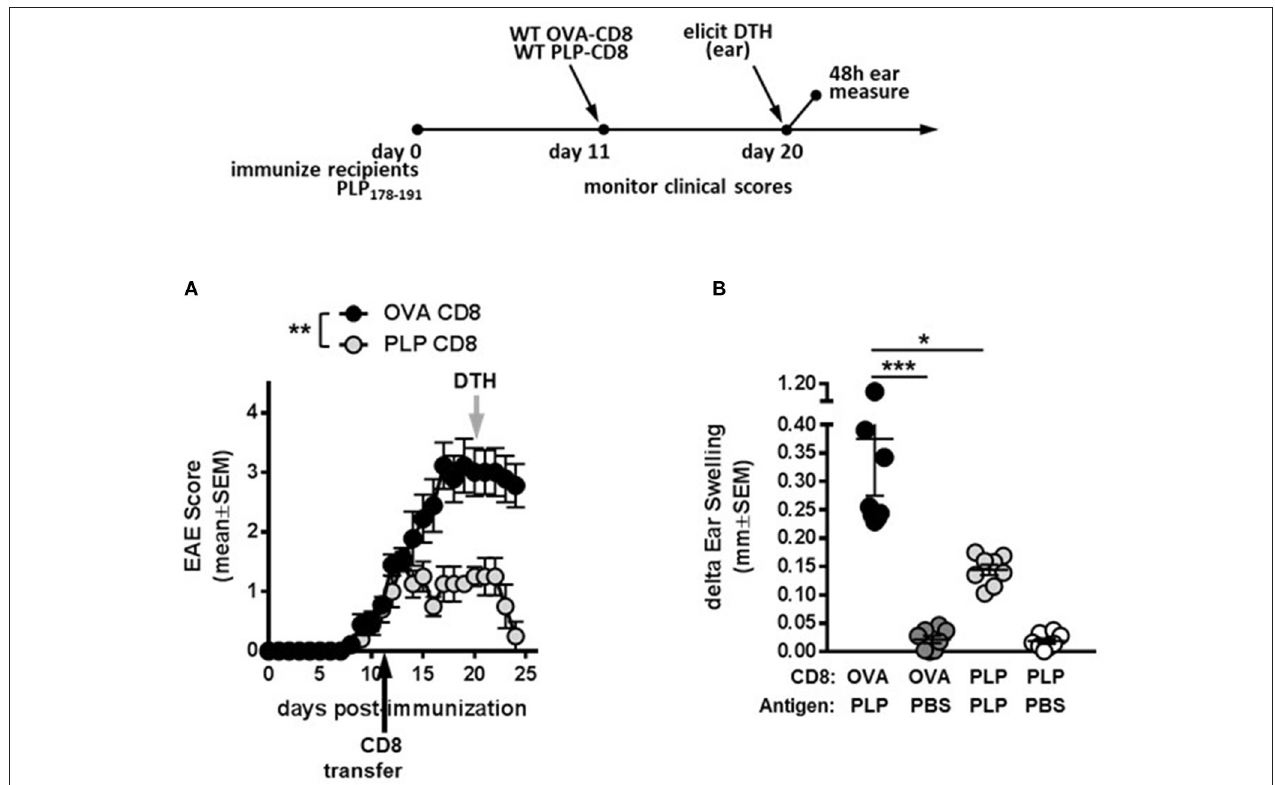
FIGURE 2 | PLP-specific CD8T cells successfully treat ongoing demyelinating disease. (A) Recipient mice were immunized with PLP178-191 to induce EAE and disease scores were monitored. At day 11 post-immunization (post-disease onset), OVA-CD8 or PLP-CD8 were transferred (black arrow). n = 8 per group. (B) At day 20 post-immunization (gray arrow in A) , ear pinnae were injected with PLP178-191 peptide or vehicle control (PBS). Ear swelling was measured at 48h post-ear challenge. n = 8 per group. * p < 0.05; ** p < 0.01; *** p <